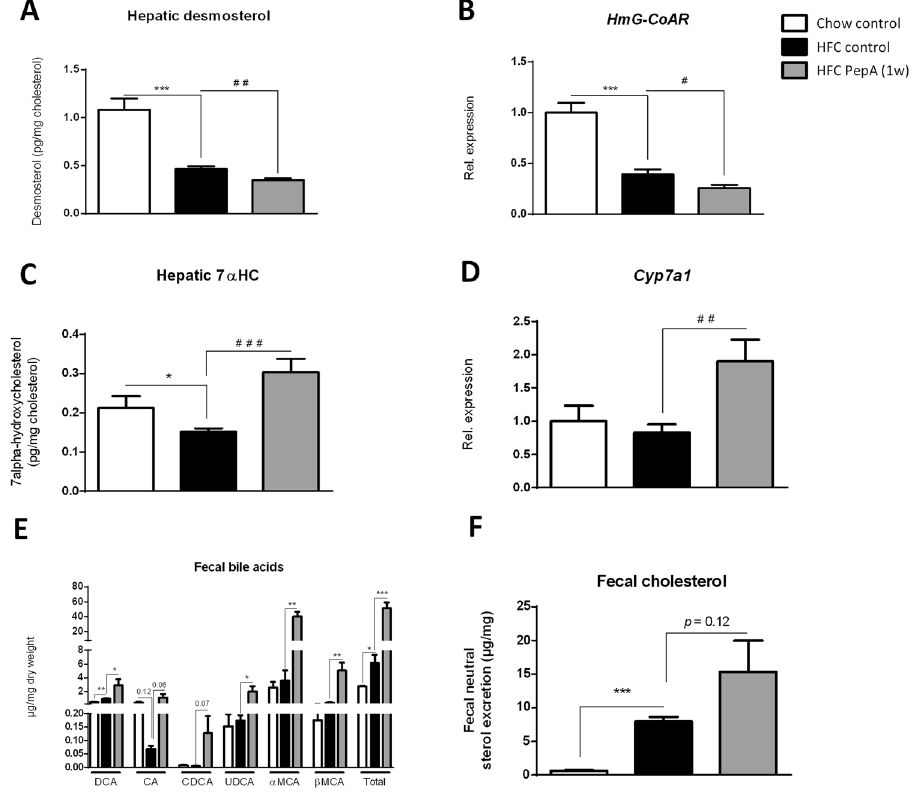
Figure 4. Hepatic de novo synthesis and degradation of cholesterol. ( A,C ) Hepatic concentrations of desmosterol ( A ) and 7 alpha-hydroxycholesterol (7 α HC; C ). Both values are shown relative to the hepatic cholesterol concentrations. ( B,D ) Gene expression analysis of HmG-CoAR and Cyp7a1 . ( E,F ) Fecal bile acid ( E ) and cholesterol levels ( F ). Both measurements are relative to mg dry weight of the fecal sample. Gene expression data are shown relative to control mice on chow diet. Error bars represent ± SEM; * indicates p ≤ 0.05 and *** p < 0.001 compared to mice on chow diet; # indicates p ≤ 0.05, ## p < 0.01 and ### p < 0.001 compared